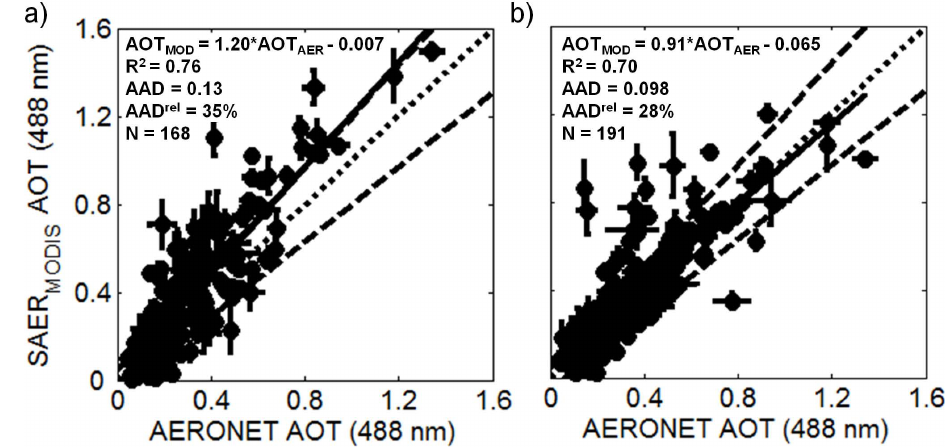
Fig. 8. Same as Fig. 6 but for a comparison of SAER MODIS and AERONET AOT at